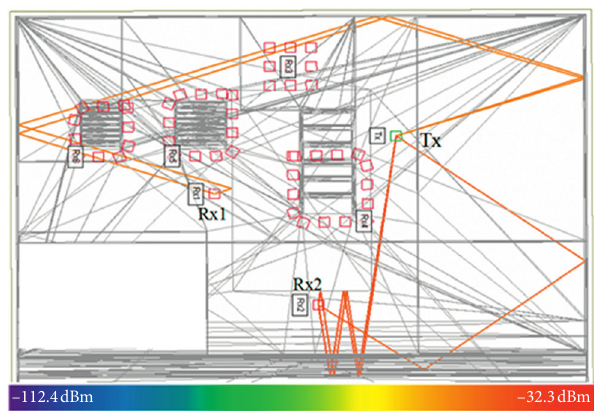
Figure 4: Simulated result of Rx1 and Rx2 receivers with several effective receiving paths.